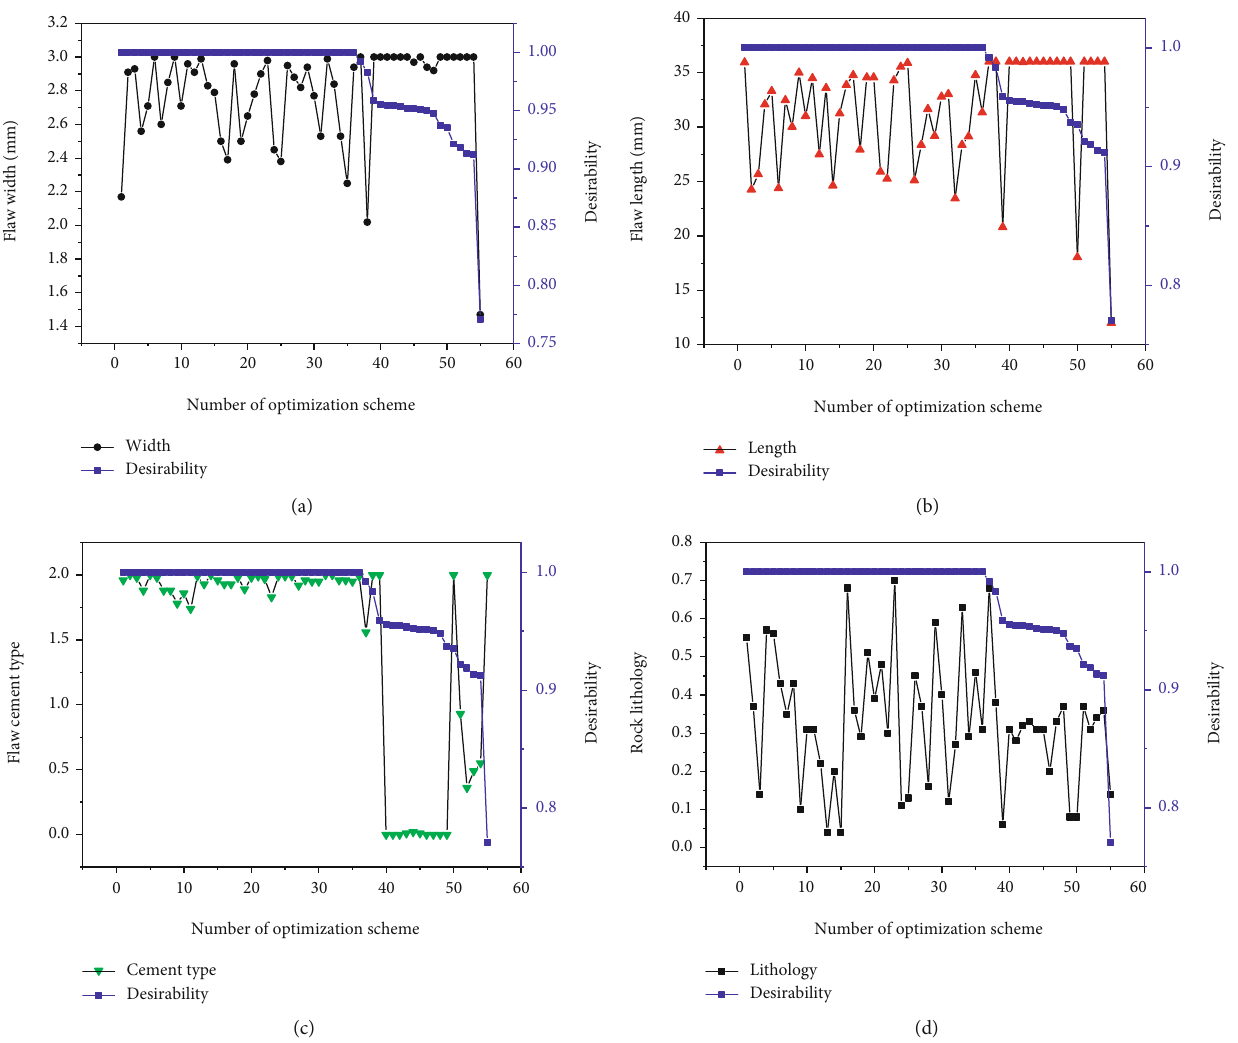
Figure 9: Optimal combinations to maximize the frost heaving force. (a – d) Plots of the optimal factors of fl aw width, fl aw length, fl aw cement type, and rock lithology,